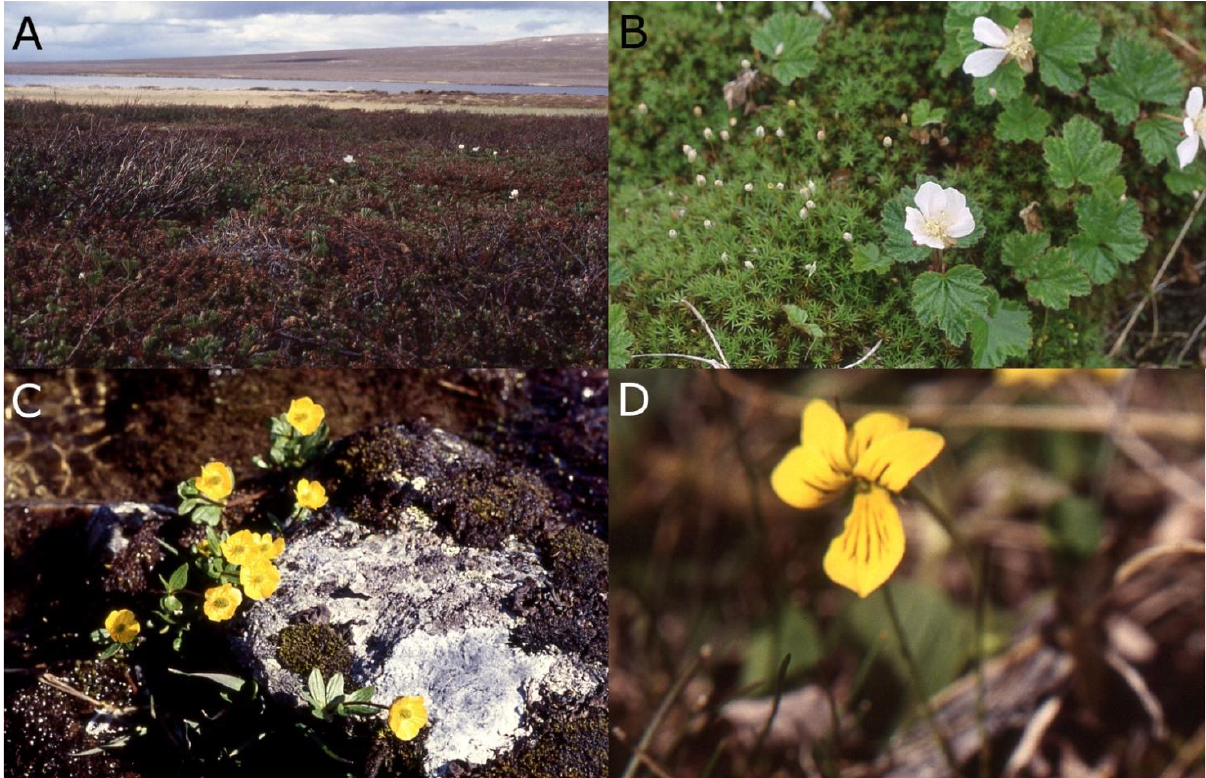
Figure 4. Flora of Seitajaure palsa mire: (A) Palsa with Salix sp., Empetrum nigrum subsp. hermaphroditum and flowering Rubus chamaemorus , June 1996; (B) Rubus chamaemorus , July 1996; (C)